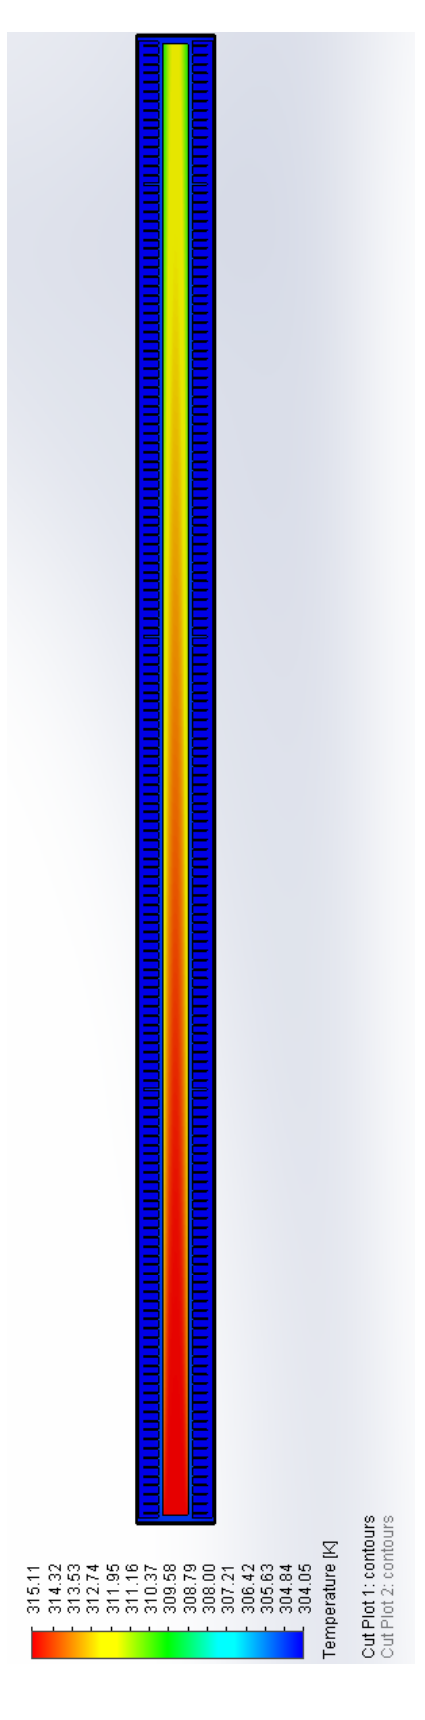
Figure 12. Section side view of temperature plot with the scale of measurement optimize for R134a internal